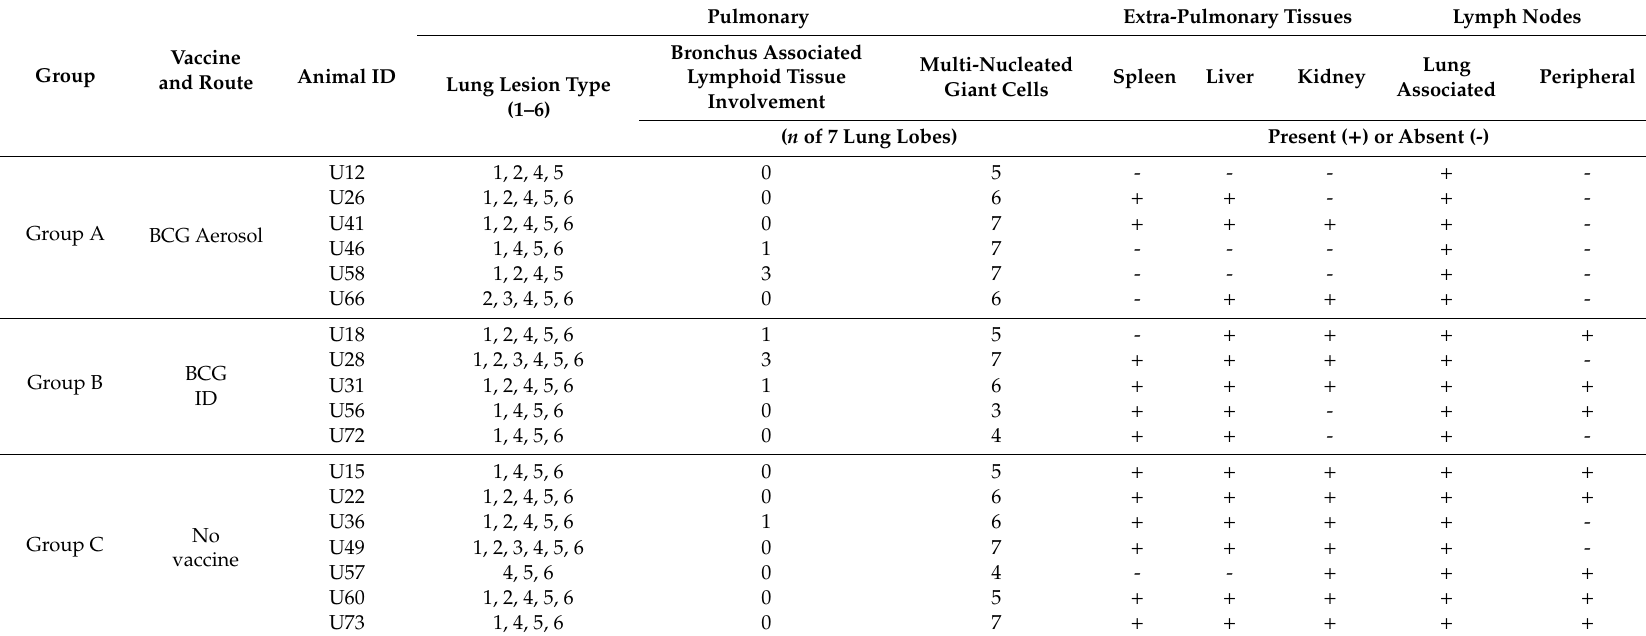
Table 2. Occurrence of microscopic changes associated with M. tuberculosis